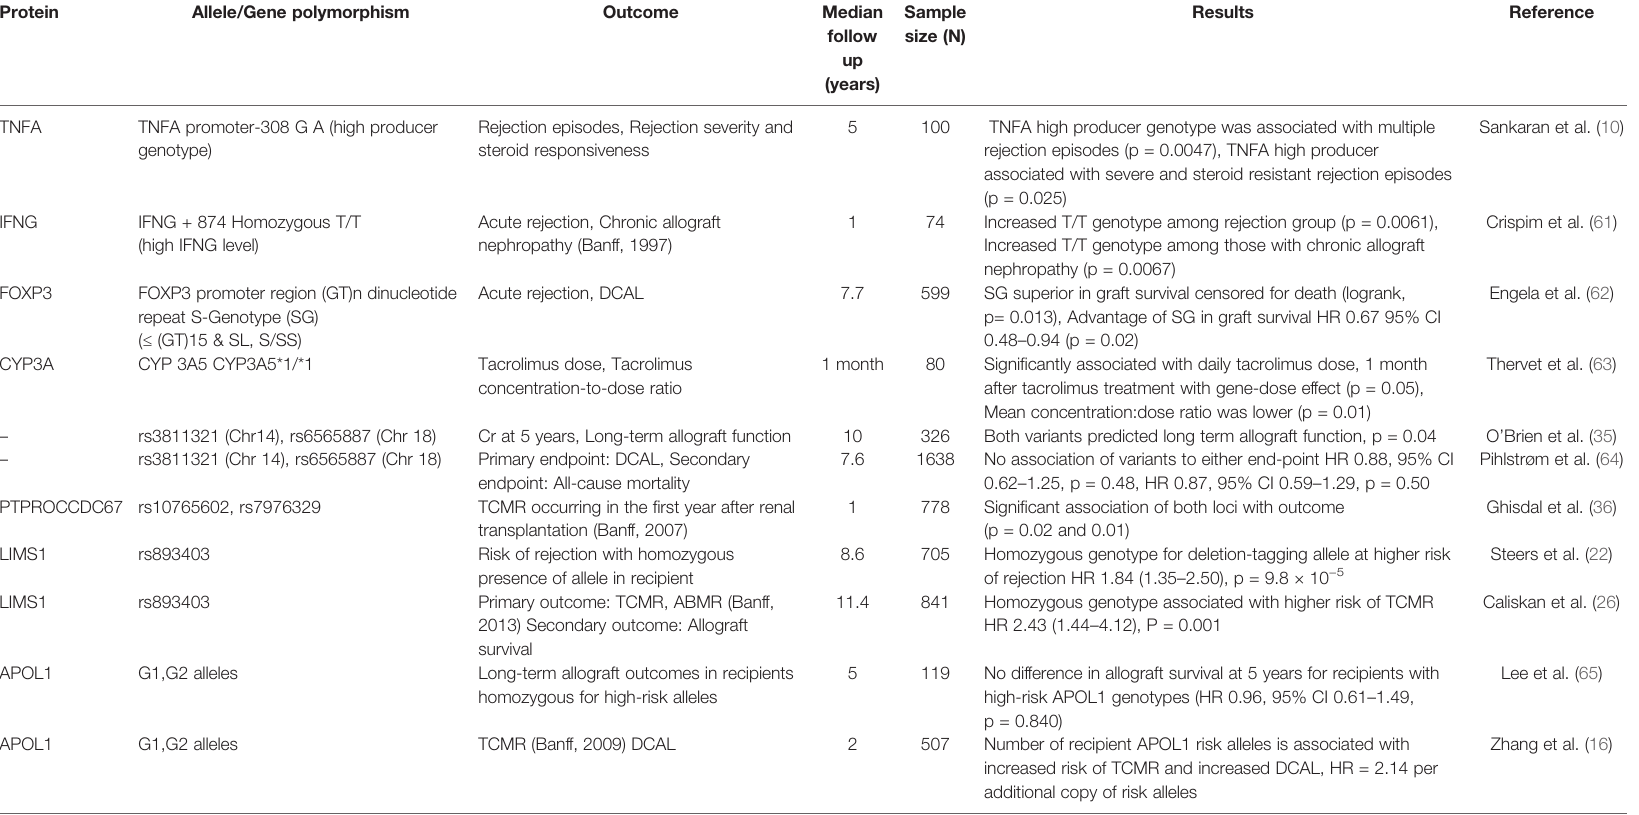
TABLE 2 | Recipient variants and allograft